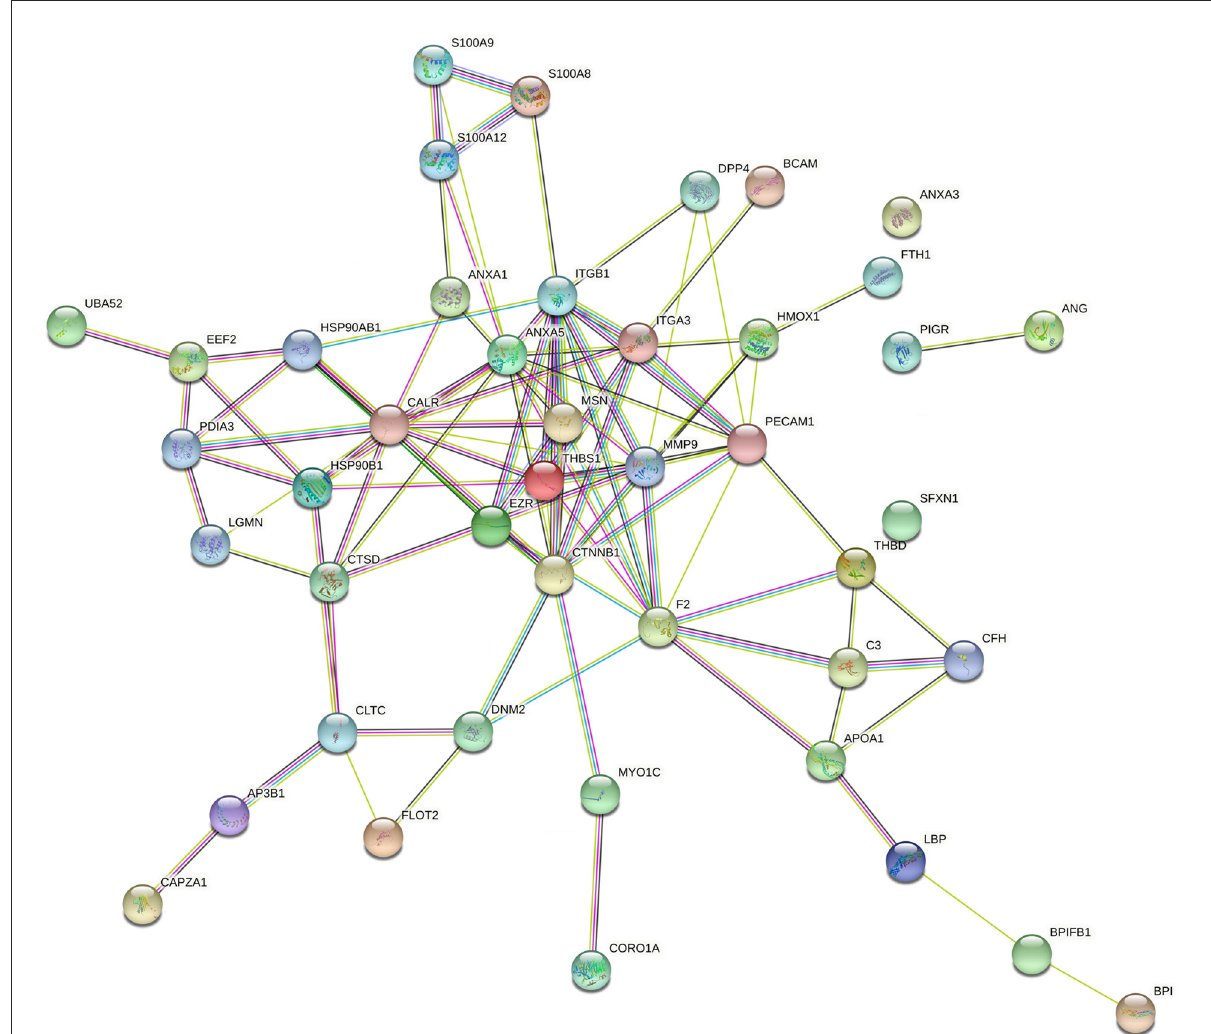
FIGURE6 The PPI networks of differentially expressed proteins (species: bovine) related to immunity. The full names of the proteins in this figure were presented as below: CALR, calreticulin; LGALS9, galectin-9; C3, complement C3; EPB42, protein 4.2; HSP90B1, endoplasmin; CORO1A, coronin-1A; ANXA1, annexin A1; MMP9, matrix metalloproteinase-9; AP3B1,AP-3 complex subunit beta-1; BPI, bactericidal permeability-increasing protein; THBS1, thrombospondin-1; ANG1, angiogenin-1; S100A12, protein S100-A12; LBP, lipopolysaccharide-binding protein; ANXA5, annexin A5; S100A8, protein S100-A8; S100A9, protein S100-A9; HSP90AB1, heat shock protein HSP 90-beta; DHX9,ATP-dependent RNA helicase A; CAPZA1, f-actin-capping protein subunit alpha-1; GPI, glucose-6-phosphate isomerase; CLTC, clathrin heavy chain 1; DNM2,dynamin-2;F2, prothrombin; THBD, thrombomodulin (fragment); CFH, complement factor H; EEF2, elongation factor 2; BPIFB1, BPI fold-containing family B member 1; PDIA3, protein disulfide-isomerase A3; FLOT2, flotillin-2; UBA52, ubiquitin-60S ribosomal protein L40; MSN, moesin; PIGR, polymeric immunoglobulin receptor; ITGB1, integrin beta-1; LGMN, legumain; COLEC12, collectin-12; CTNNB1, catenin beta-1; SFXN1, sideroflexin-1; BCAM, basal cell adhesion molecule; HMOX1, heme oxygenase 1; ANXA3, annexin A3; MYO1C, unconventional myosin-Ic; CTSD, cathepsin D; APOA1, apolipoprotein A-I; DPP4, dipeptidyl peptidase 4; ITGA3, integrin alpha-3; EZR, ezrin; PECAM1, platelet endothelial cell adhesion molecule; FTH1, ferritin heavy